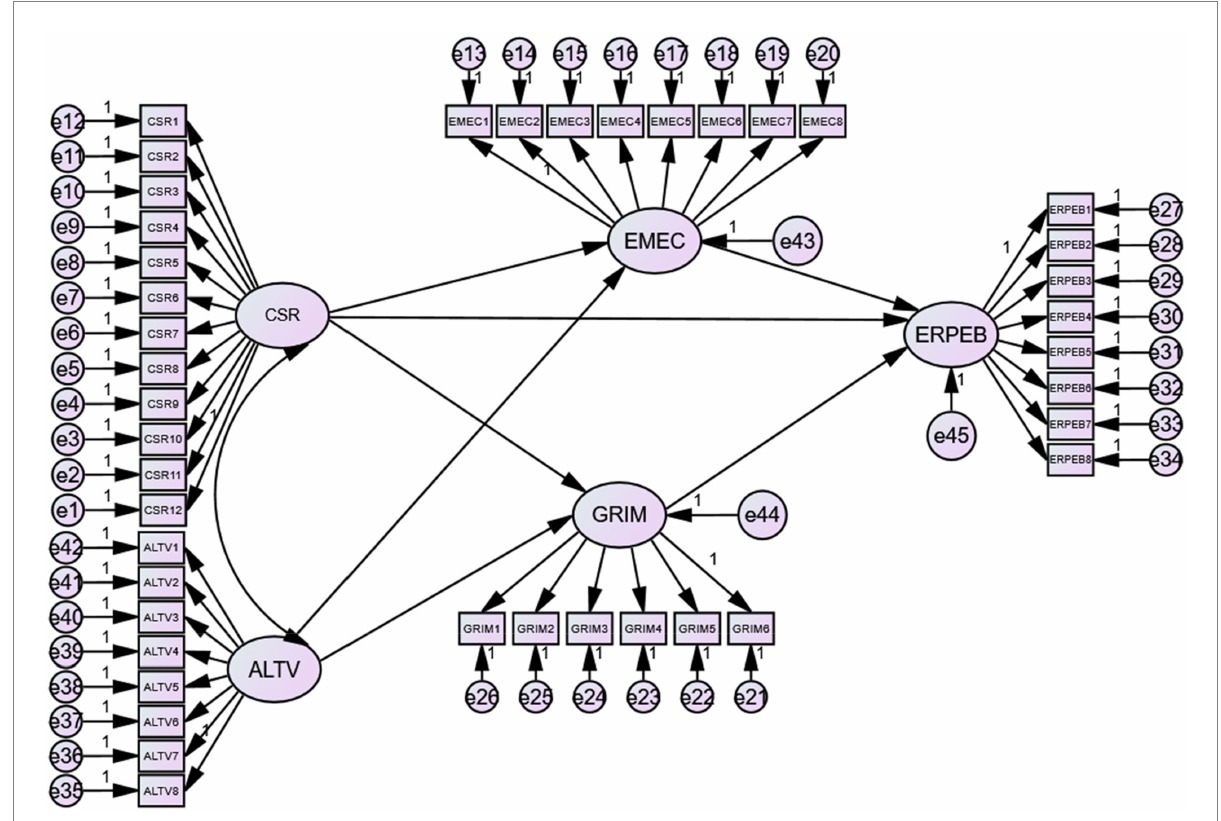
FIGURE 1 The hypothesized structural model: CSR, Corporate Social Responsibility (X); EMEC, Employee Environmental Commitment (M1); GRIM, Green Intrinsic Motivation (M2); ERPEB, Energy Related Pro-Environmental Behavior (Y); ALTV, Altruistic Values (W); CSR_x_ALTV, Interaction